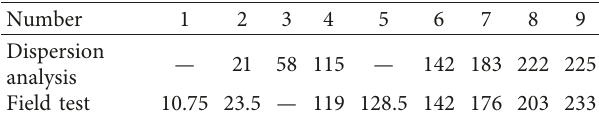
Figure 14: Dispersion curves of the subway tunnel modeled as a hollow cylinder shell by the PiP model. Table 2: The dispersion analysis of the subway tunnel mode fre- quency distribution and comparison with the field test